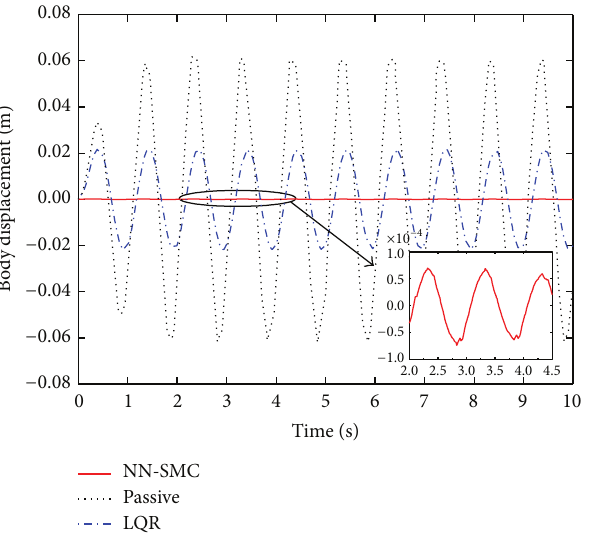
Figure 6: Body displacement (Case 1).